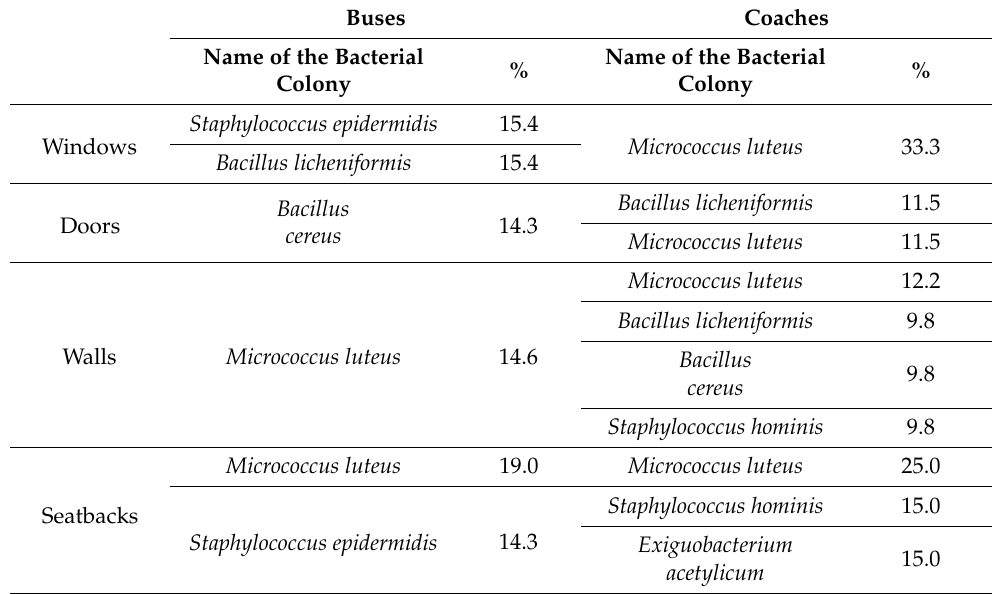
Table 2. Percentage of bacterial colonies on individual surfaces.